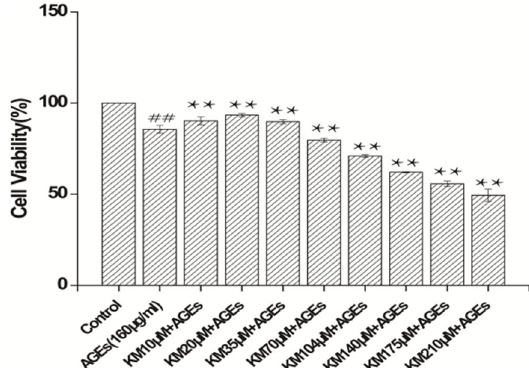
Figure 1. Kaempferitrin (KM) increases the cell viability of advanced glycation end (AGE)-treated glomerular mesangial cells (GMCs). GMCs were pre-treated with different concentrations of KM and then stimulated with AGEs (160 μg/mL) for 24 h. The results are presented as mean ± standard errors of the means (SEM). ** p < 0.01, vs. AGEs group; ## p < 0.01, vs. control group.